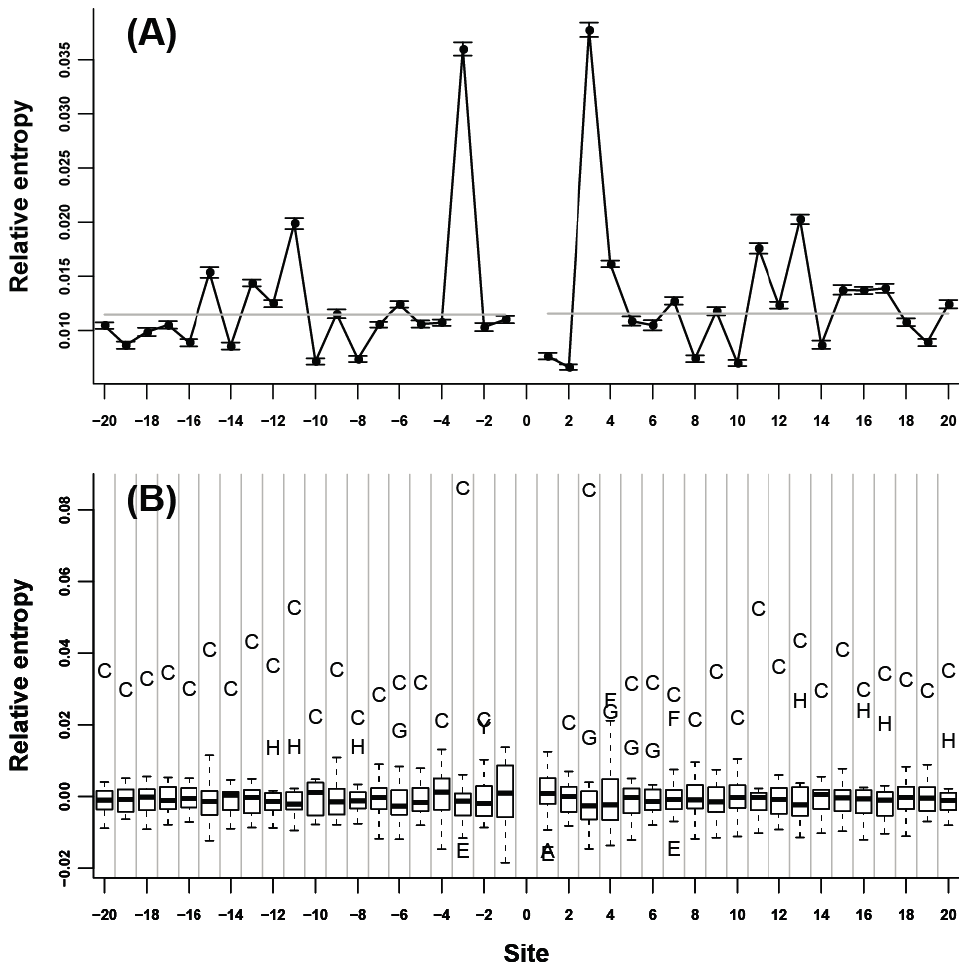
Figure 2. Neighbor preference pattern of the amino acid C. ( A ) Relative entropies of the neighboring sites of C of N - and C -termini; ( B ) Boxplot of the 20 relative entropies at each flanking site of the amino acid C.